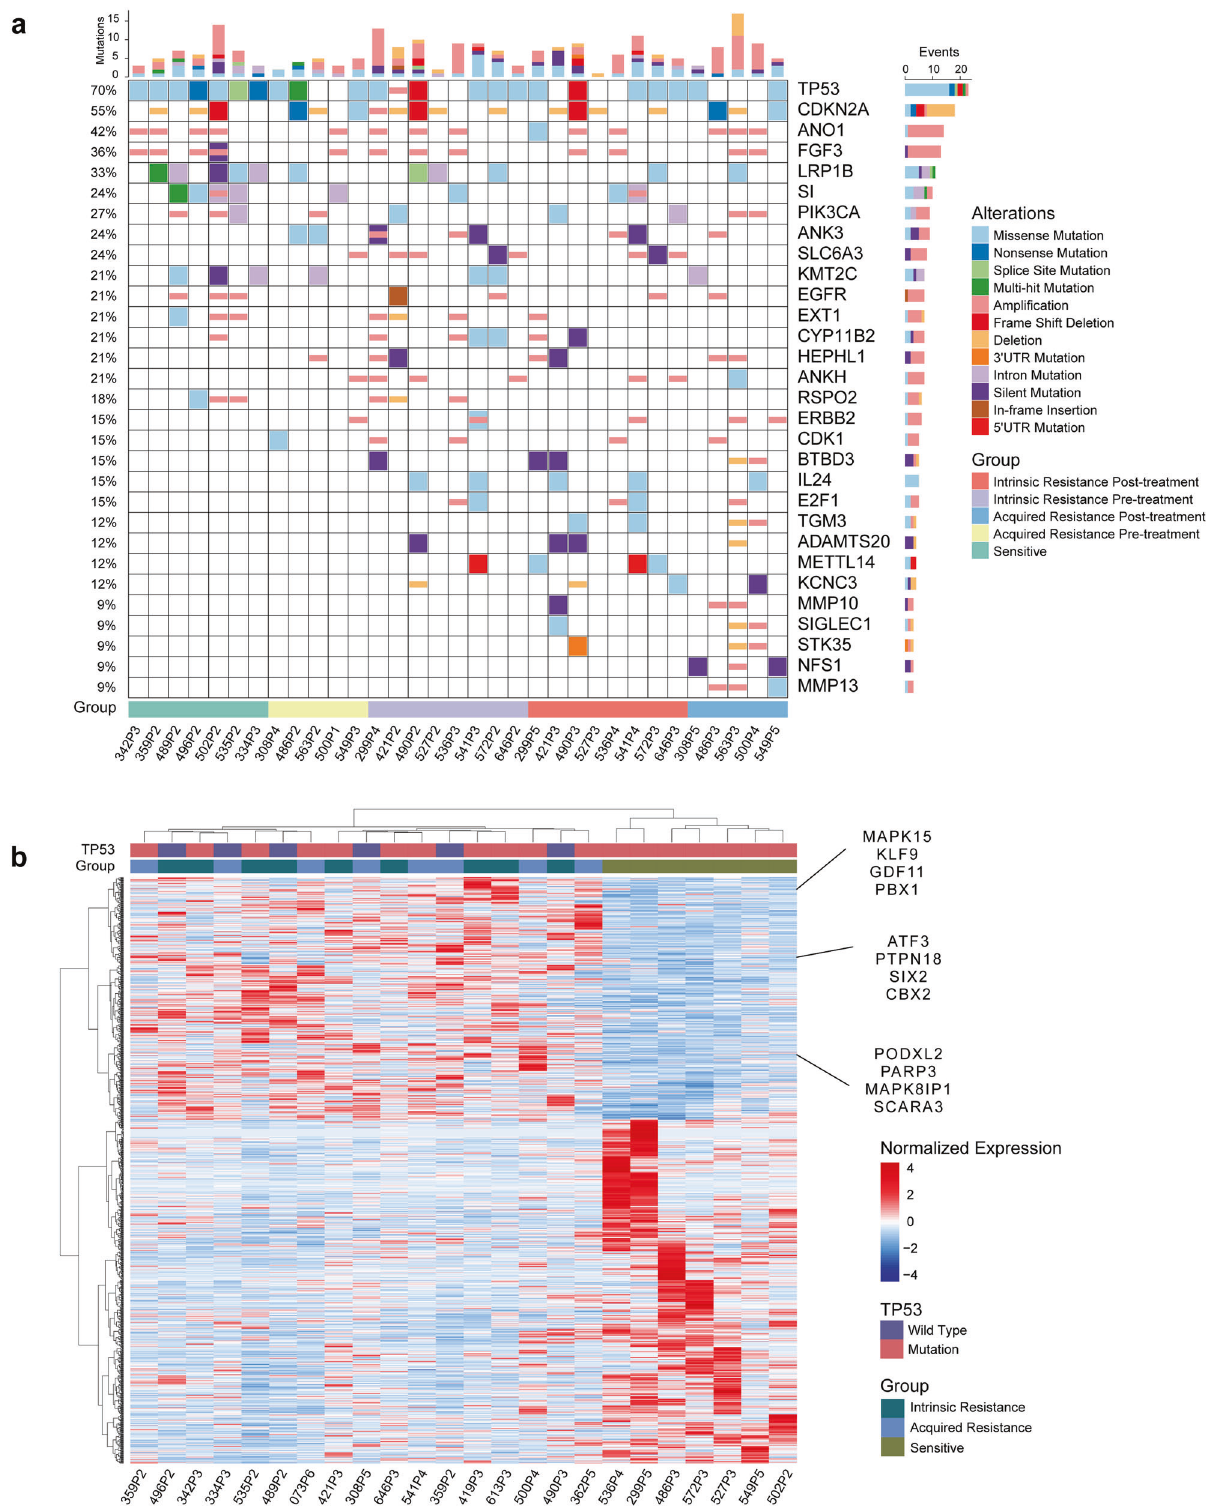
Fig. 2 Genetic and transcriptomic landscape of HNSCC PCT. a Genetic matrix depicting the genomic landscape of the cetuximab PCT cohort. Copy number alterations and mutational events in select genes of interest are shown. Parameters (shown at the right) include alterations and groups. CNV, copy number variation; SNV, single-nucleotide variant. The x axis represents each sample ID and the y axis represents the frequency of CNVs and SNVs in the genes. The bar graph indicates the number of gene alterations in each sample. b Unsupervised hierarchical clustering heatmap showing the relative gene expression levels of the 2500 selected variable genes from an RNA-seq analysis of resistant and sensitive PDXs. Twelve genes of interest are labeled on the right side of the heatmap